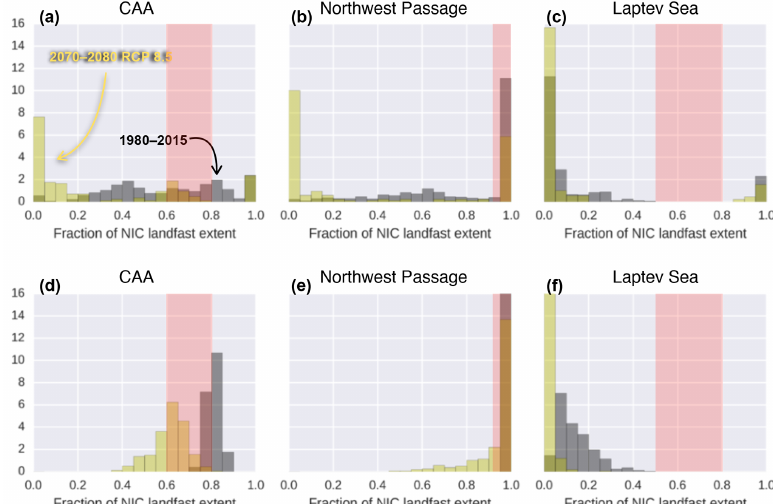
Figure 8. (a) Distribution (across simulations and years) of the fraction of NIC landfast ice extent (magenta line in Fig. 2b) covered by slow, packed ice with a duration of more than 5 months over the CAA for the 1980–2015 period in black and the 2070–2080 period of the RCP 8.5 scenario in yellow. (b) Same as (a) but over the Northwest Passage. (c) Same as (b) but over the Laptev Sea. (b) – (f) Same as (a) – (c) but for the CESM-LE. Note that in (e) – (f) the highest bins go to 21 and 19, respectively. In red shading, we identify the range of observations over the same period, as seen in Fig. 7, disregarding PIOMAS in the Laptev